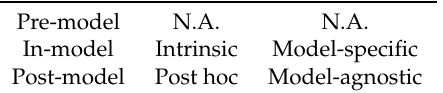
Table 2. Association between interpretability